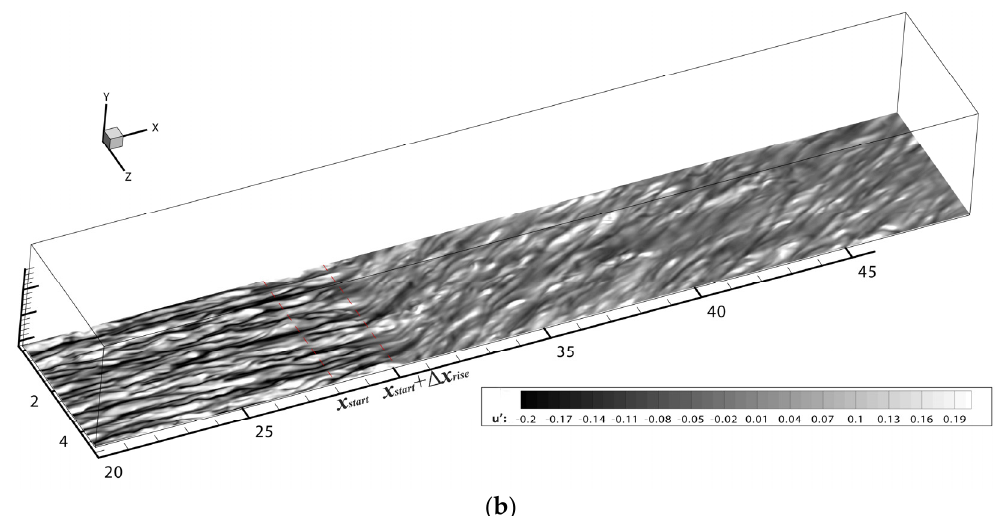
Figure 4. Turbulent coherent structures visualized with iso-surface of λ ci ( a ) and velocity streak at y ` “ 10 ( b ).